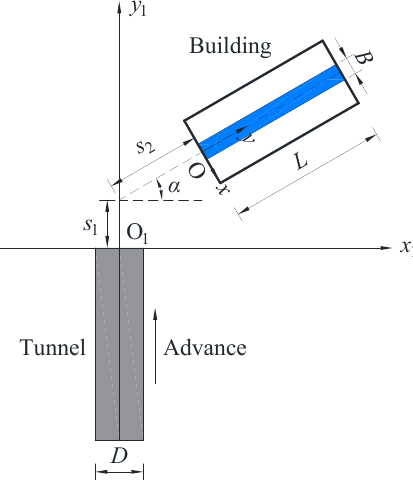
Figure 2. Plan view of tunnel and building.